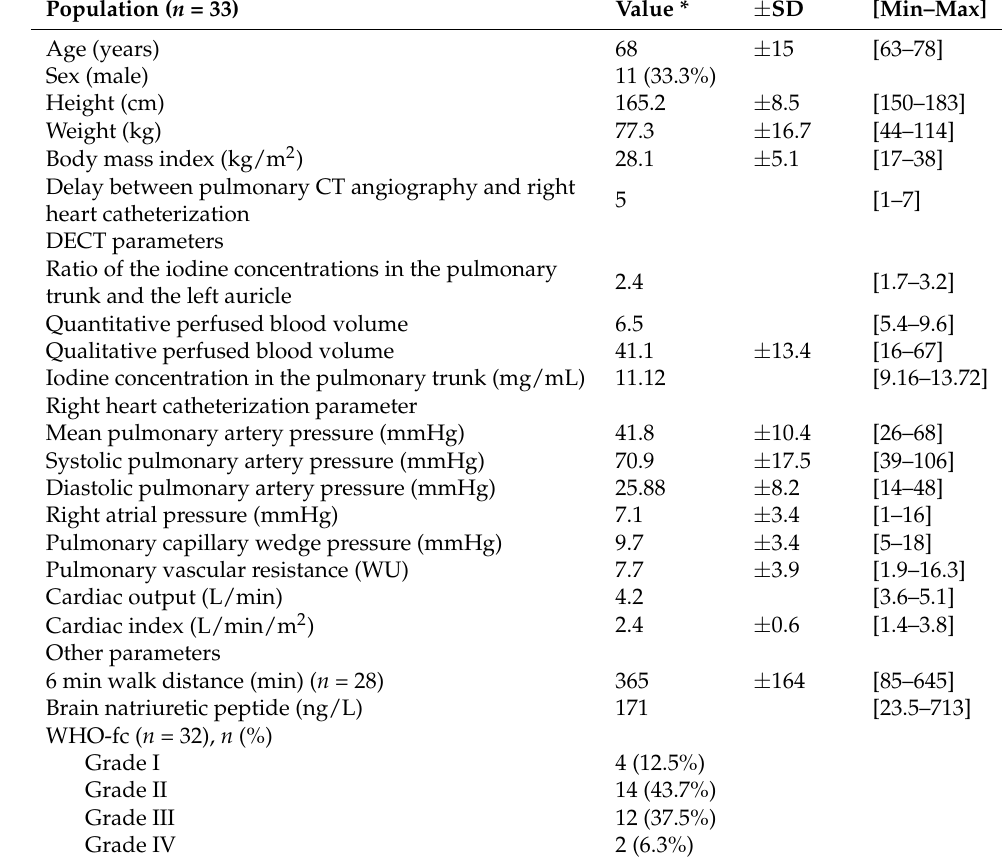
Table 1. Patients’